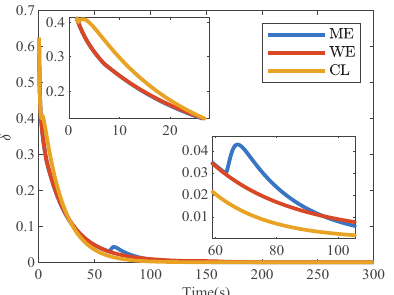
Figure 6. Comparison of SoC imbalance index under different strategies in Case